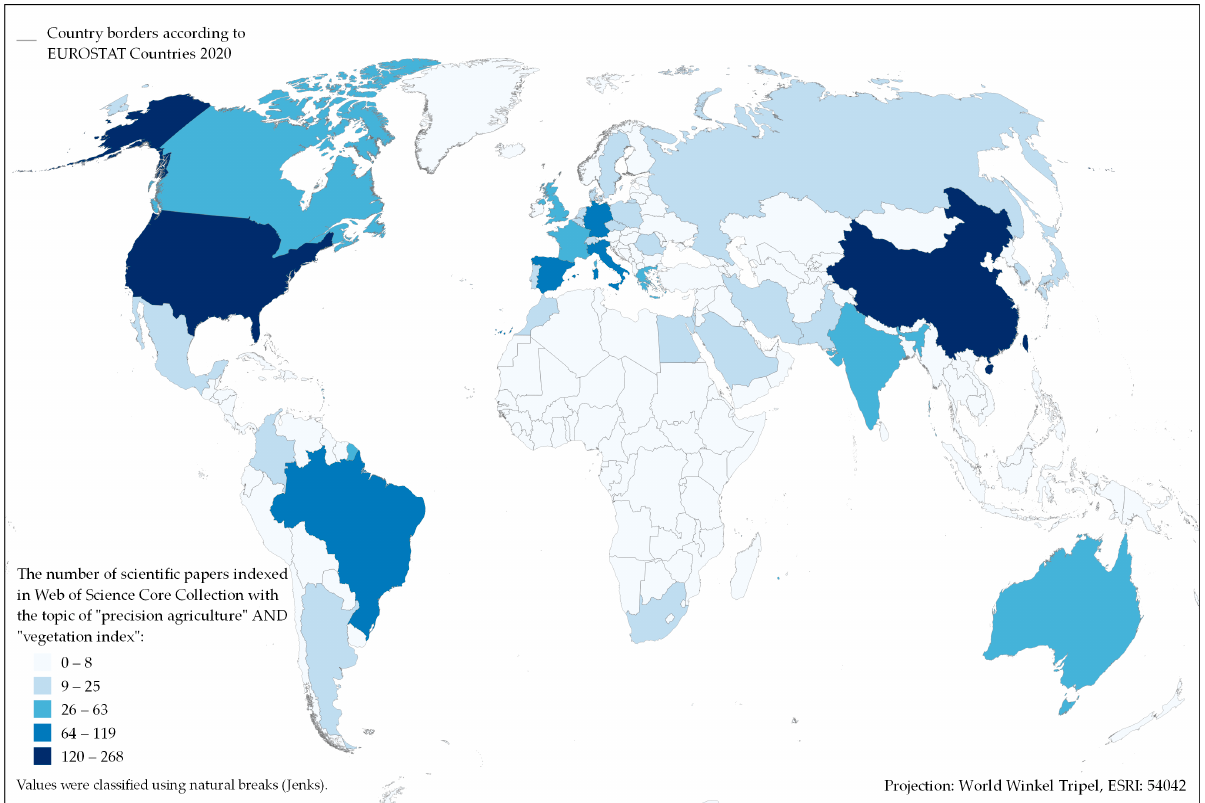
Figure 3. Global map of the number of scientific papers indexed in WoSCC since 2010 with the topic of “precision agriculture” AND “vegetation index”.